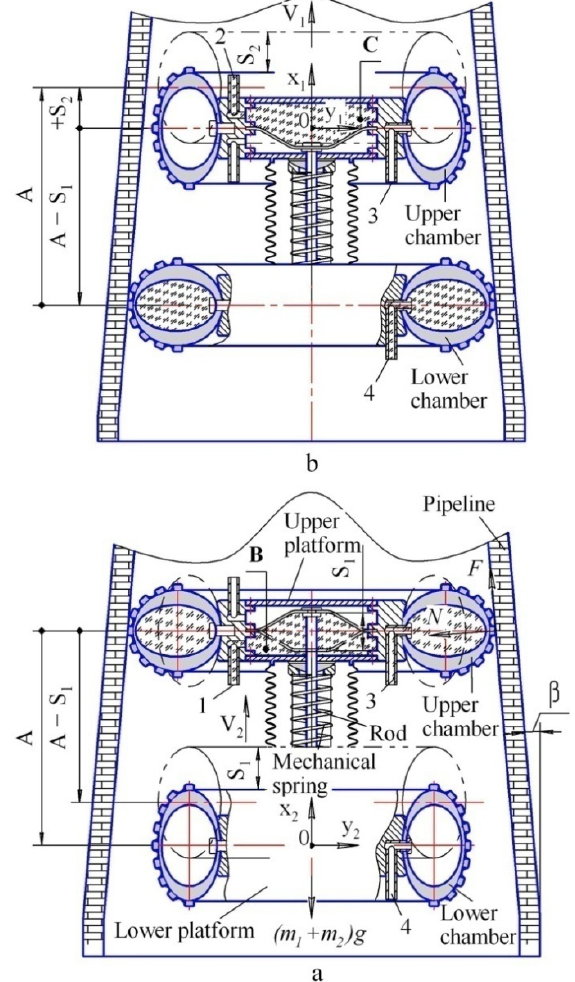
Figure 2. Longitudinal section of the module along the A-A plane (see Figure 1): m 1 , m 2 – respectively, the mass of the upper and lower platforms; g = 9,8 m/c 2 (cid:1311) gravity acceleration As a result, the distance between the upper and lower platforms is restored and equals the dimension "A." Thus, the module has moved up the pipeline to the first step, namely the value "S ". Then the cycle of 2 movement is